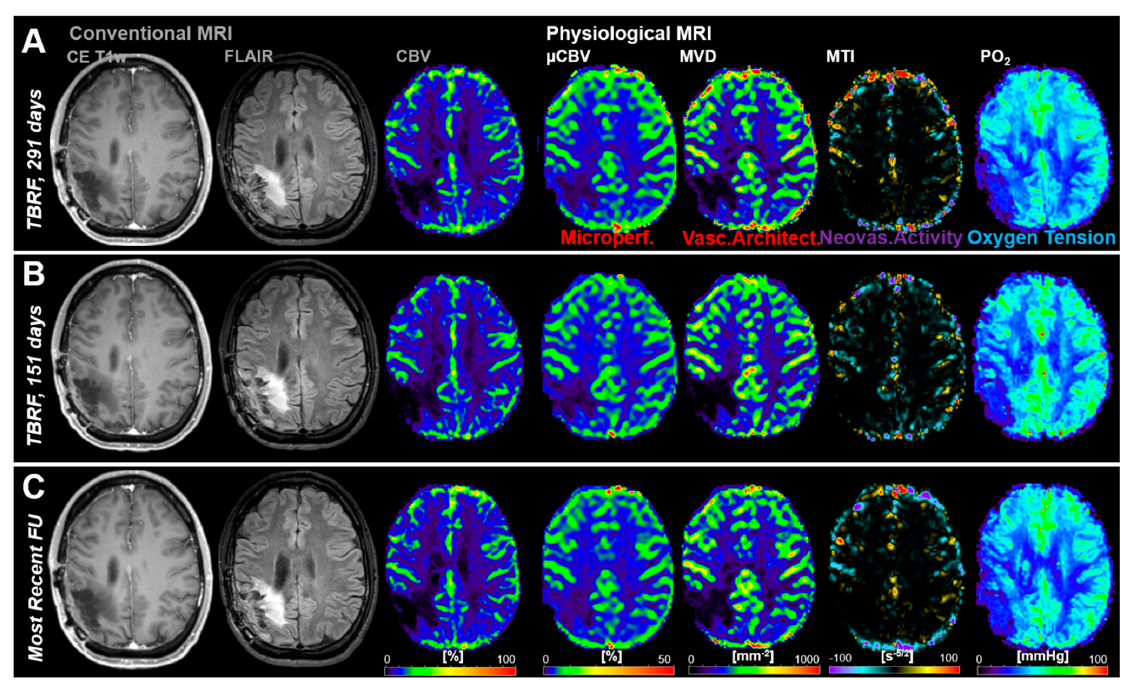
Figure 4. Follow-up MRI examinations of a 34-year-old male patient without recurrence of an anaplastic oligodendroglioma (WHO Grade III) during the study period. ( A – C ) Conventional MRI revealed no signs for radiological recurrence and physiological MRI biomarker maps showed no features for pathophysiological changes, respectively. TBRF = time before the recent follow-up (FU).